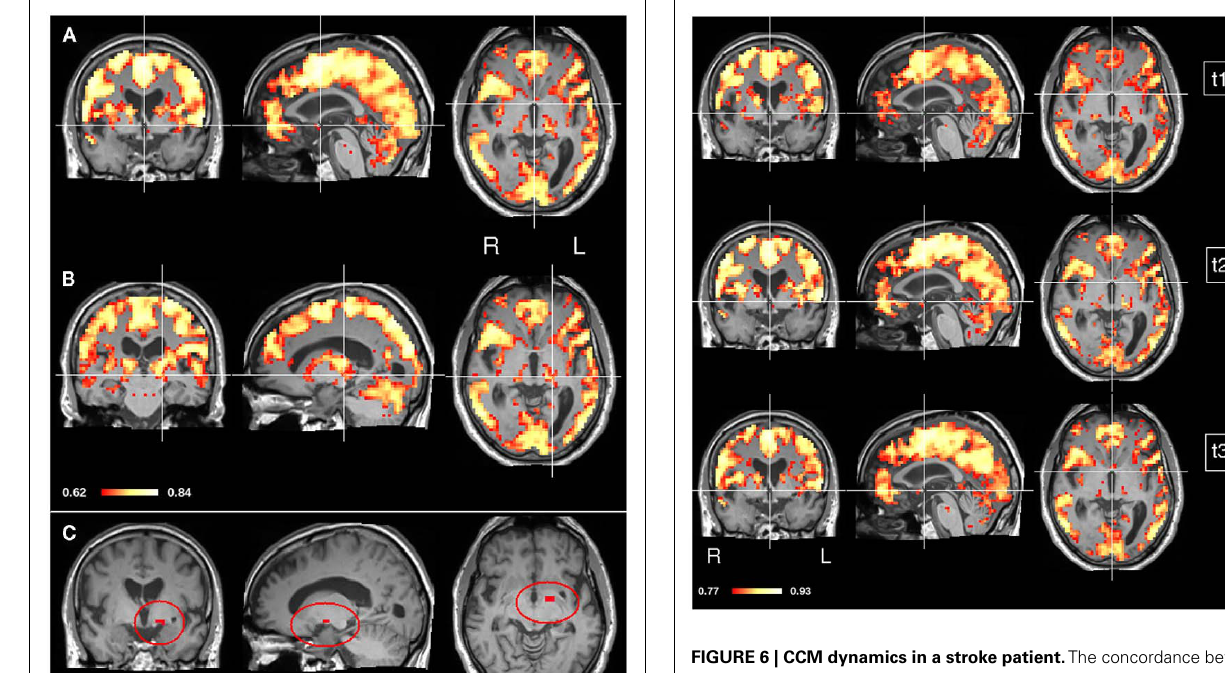
FIGURE 6 | CCM dynamics in a stroke patient. The concordance between any two consecutive time points was calculated (t1 and t2, t2 and t3, t3 and t4). MNI coordinates of slice positions are (0, 0, 0).